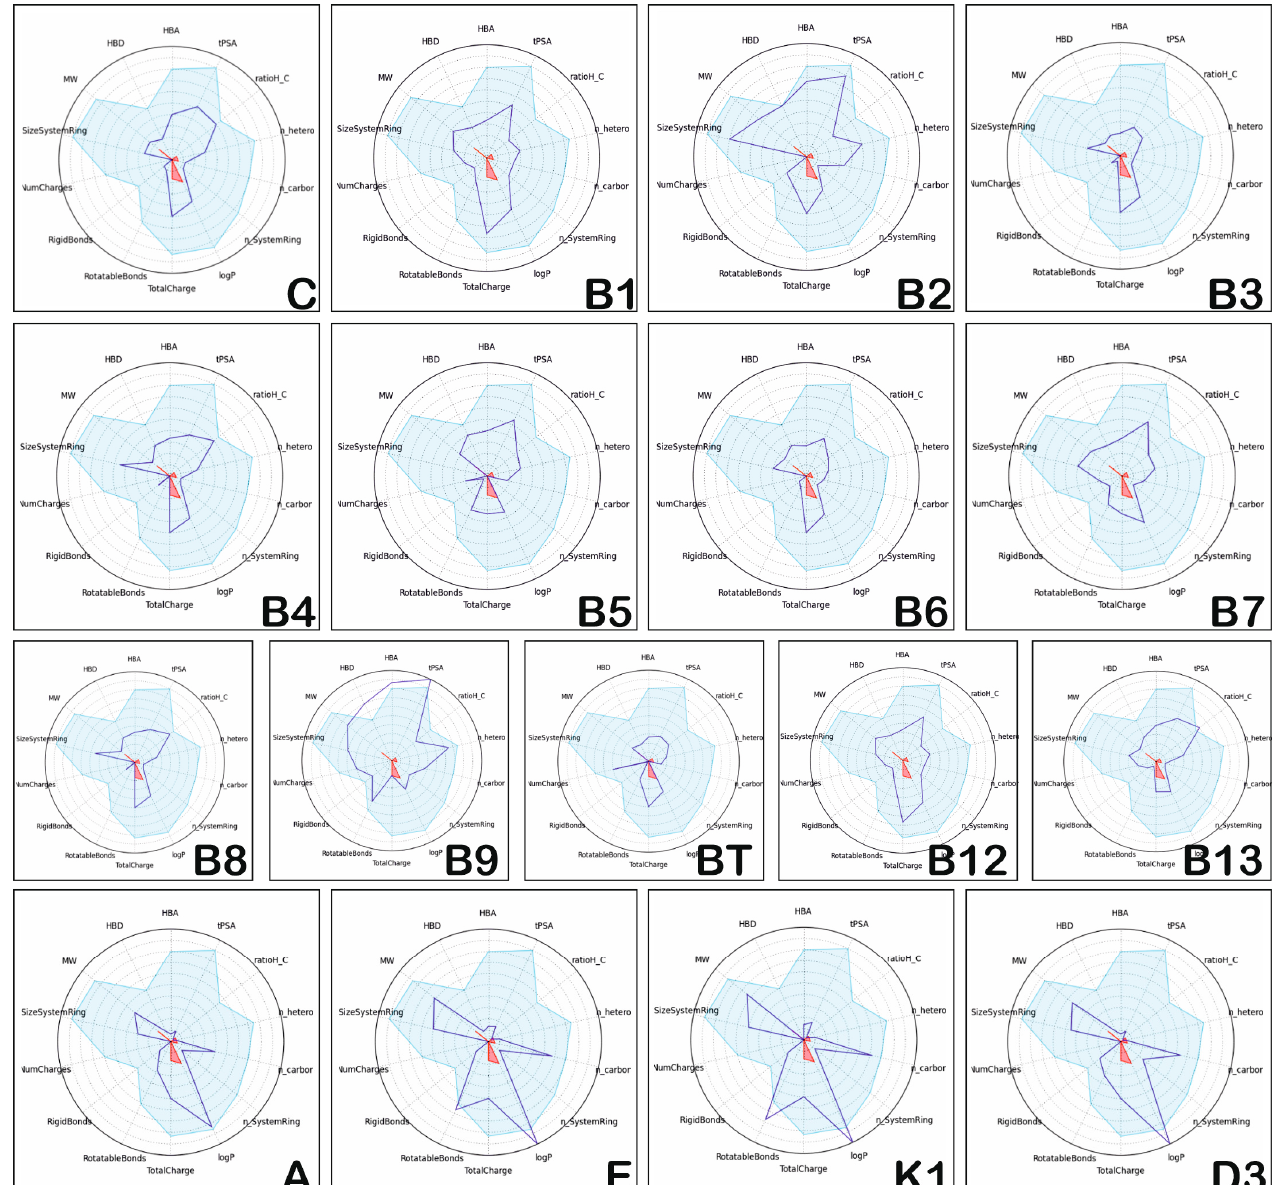
Figure 1. Position of physico-chemical properties of the hydrosoluble vitamins and liposoluble vitamins.